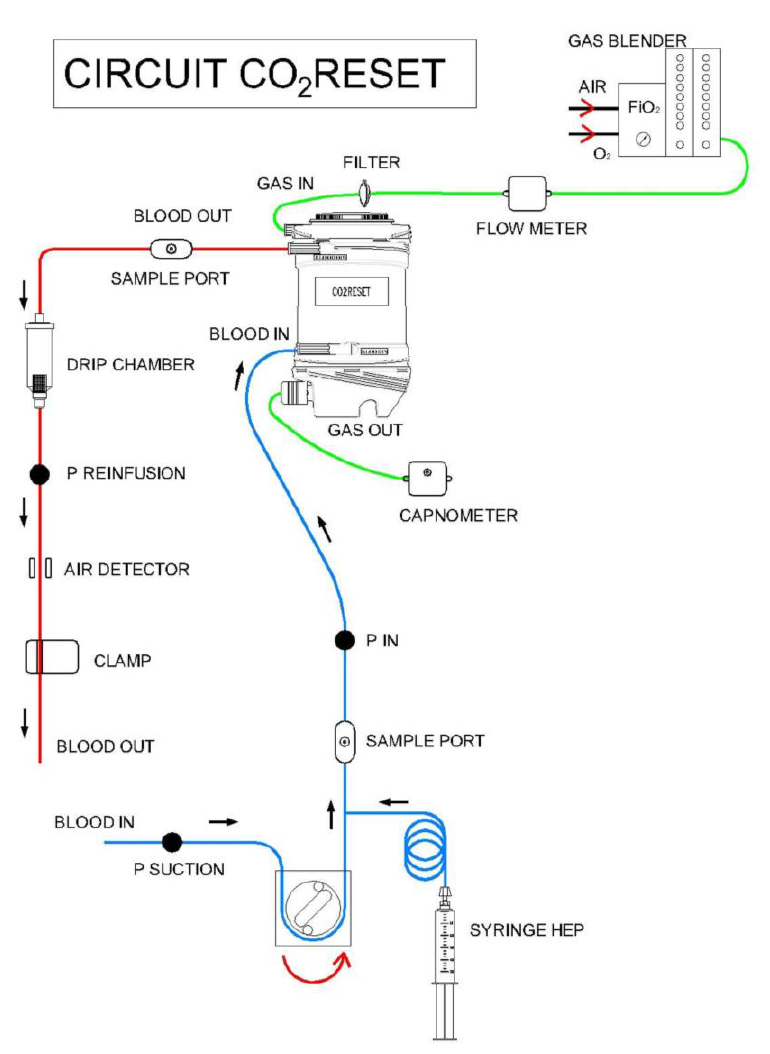
Figure 1. Schematic representation of the CO 2 RESET device. P =